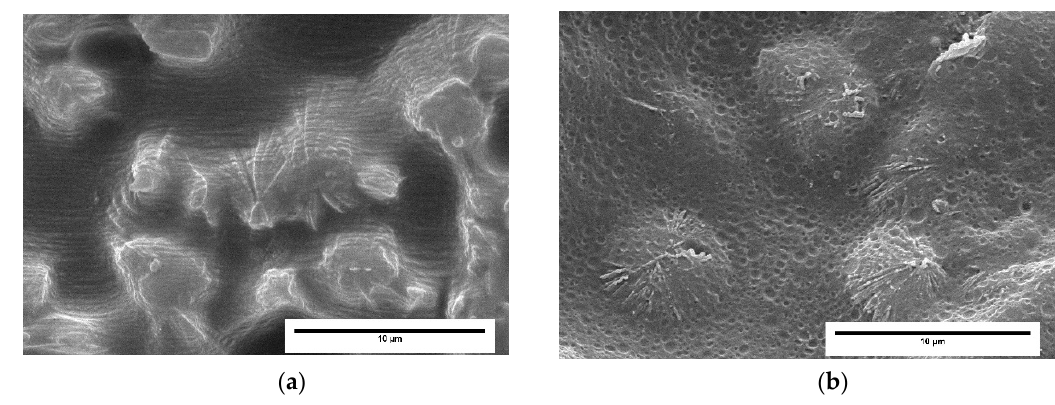
Figure 5. SEM images of a permanganic etched solid sample (215 L) at ( a ) 100 μ m and ( b ) 2000 μ m from the skin. The scale bar represents 10 μ m.